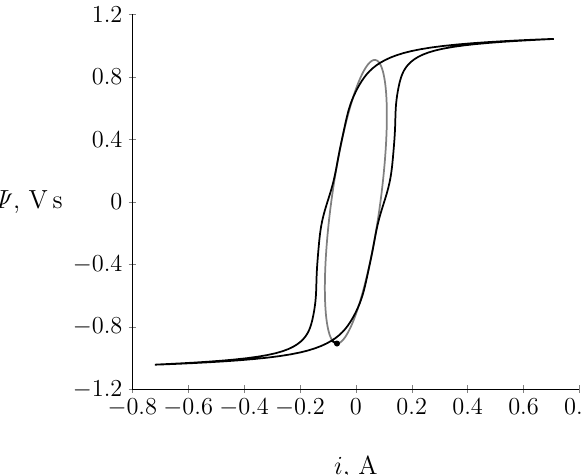
Figure 11. Steady-state phase plane for linear and nonlinear model. The point located on the curve indicates the limit cycle between the linear and nonlinear parts of the solution.